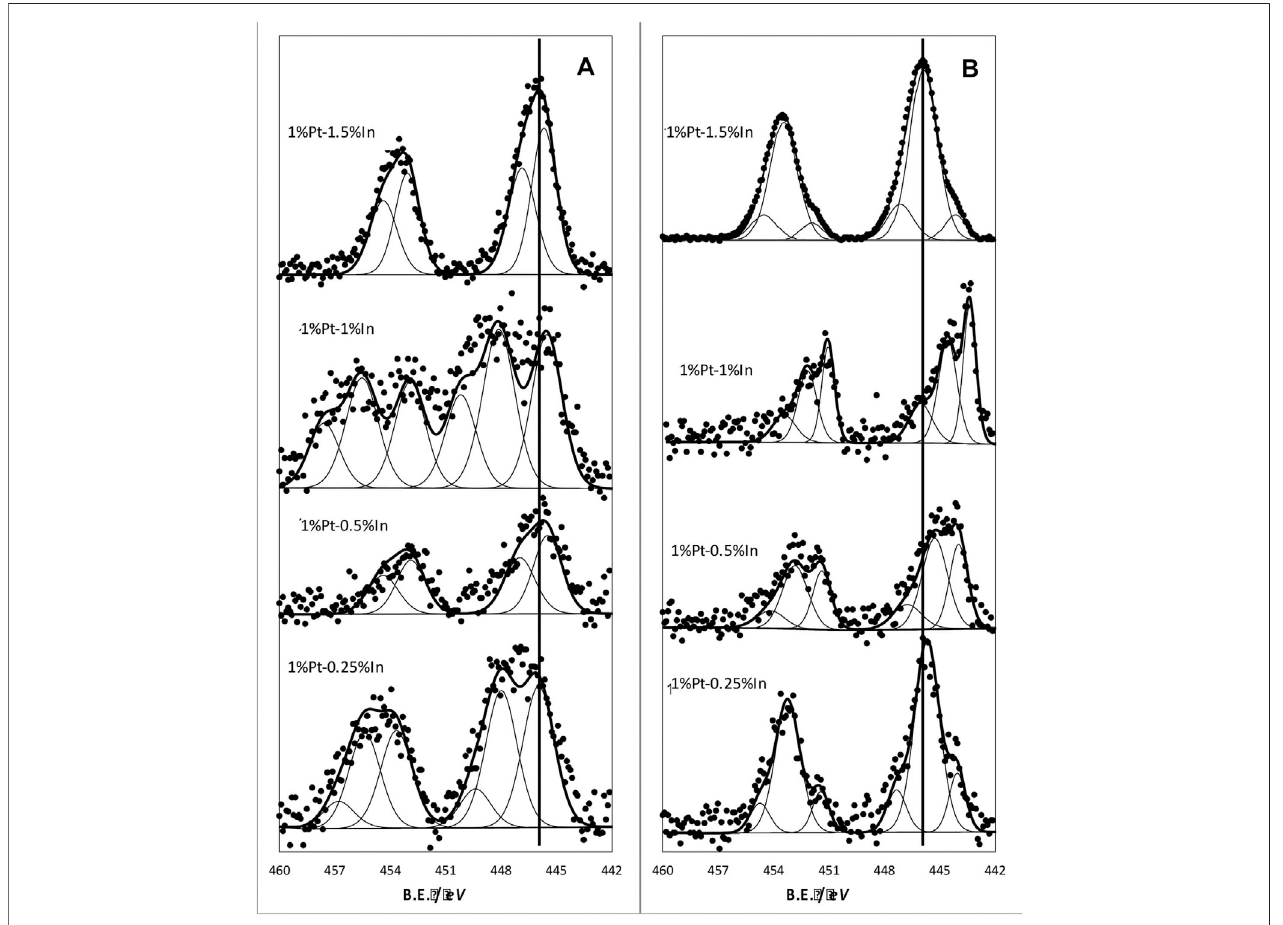
FIGURE4| In3 d corelevelspectraofthedifferentcatalysts: (A) samplestreatedat400 ° CinN 2 (B) samplestreatedat400 ° CinN 2 andfurtherreducedinhydrogen at 400 ° C.